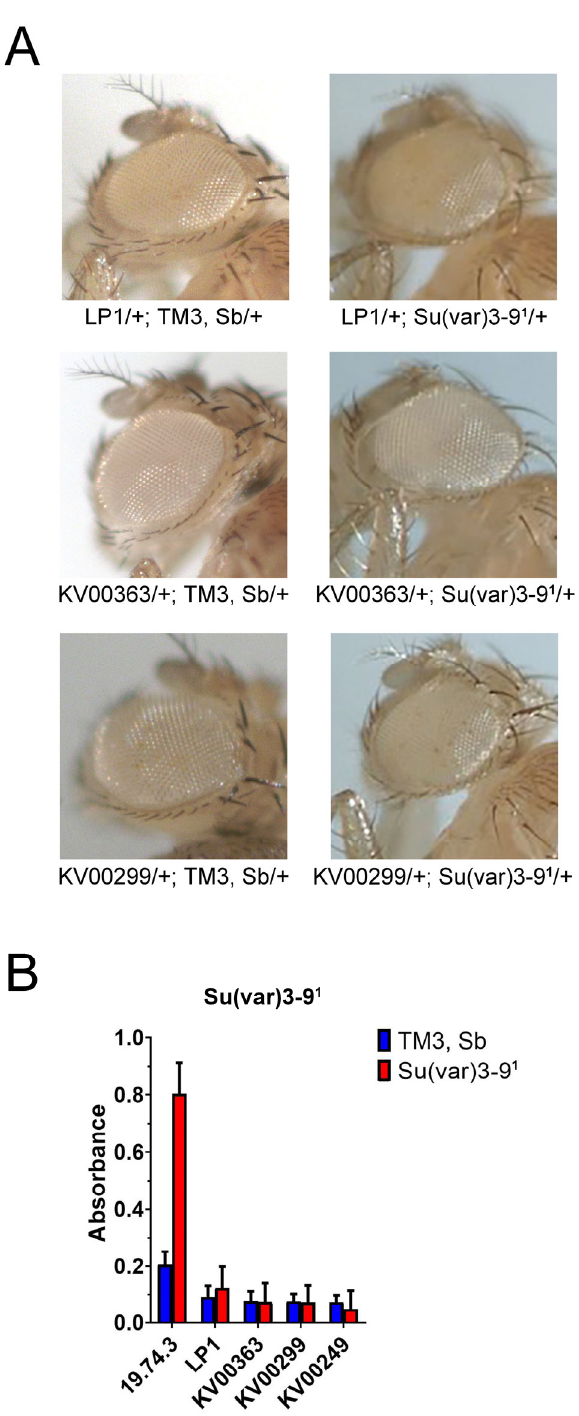
Figure 5. Effects of Su(var)3 ‐ 9 1 on silencing of Pw + reporters. ( A ) Examples of eye phenotypes of Pw + reporters in flies with or without Su(var)3 ‐ 9 1 . ( B ) Histograms summarizing the quantification of eye pigment in presence and absence of Su(var)3 ‐ 9 1 . The silencing of the Pw + reporter in 19.74.3 was efficiently suppressed, while that of KV00363, LP1, KV00299 and KV00249 was unaffected. For the scheme of crosses see Figure 1 and Materials and Methods.